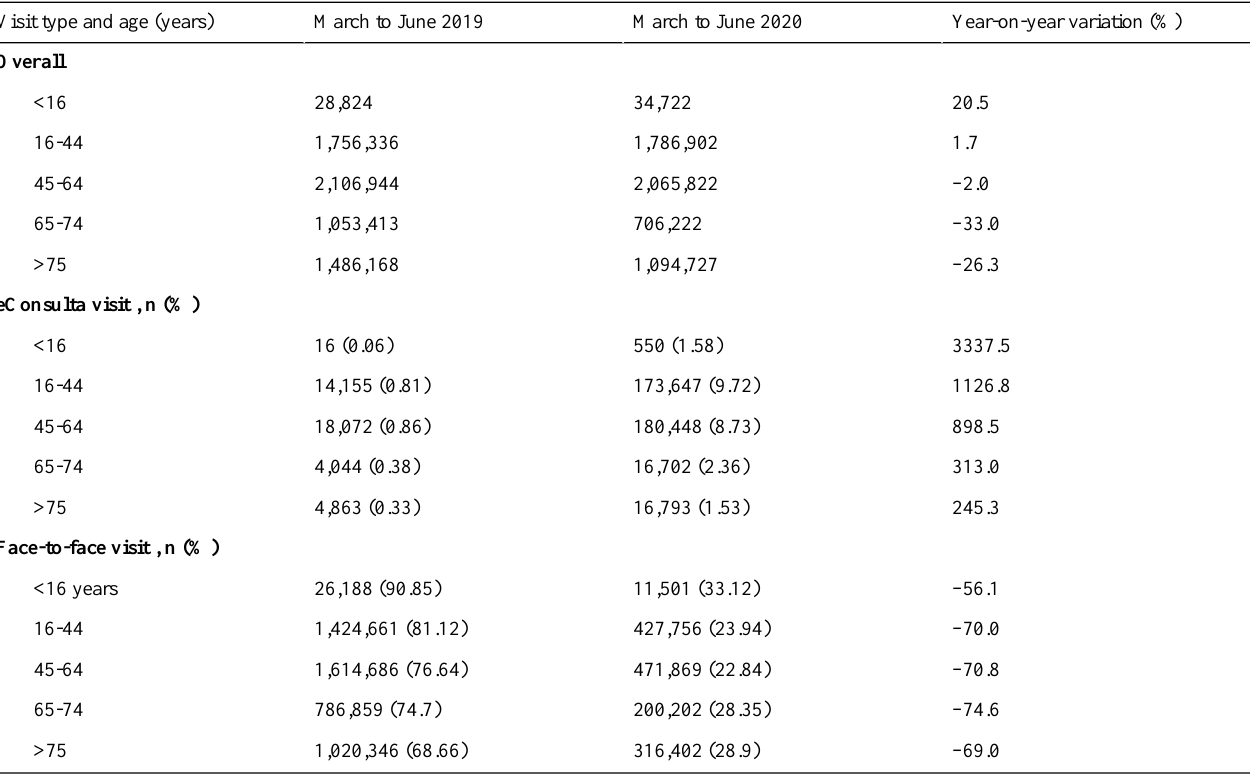
Table 5. Number of face-to-face visits and teleconsultations, classified by age group. Source: Primary Care Services Information Systems, Institut Català de la Salut, Barcelona, Spain (SISAP)